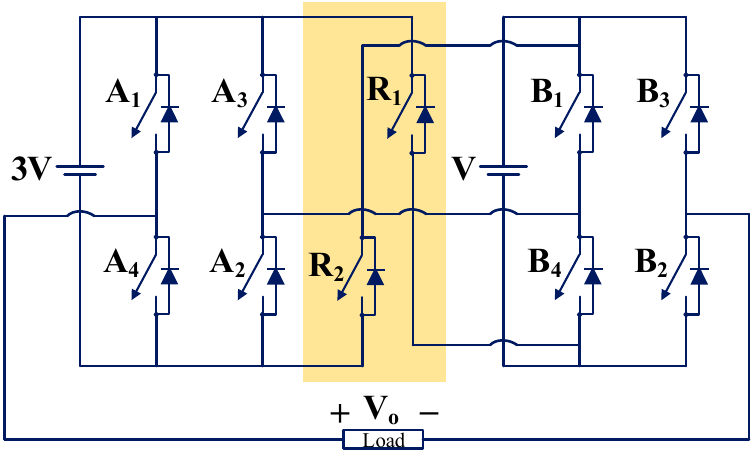
Figure 14. Single-phase nine-level CHB inverter with fault-tolerance capability (TP14) [39].